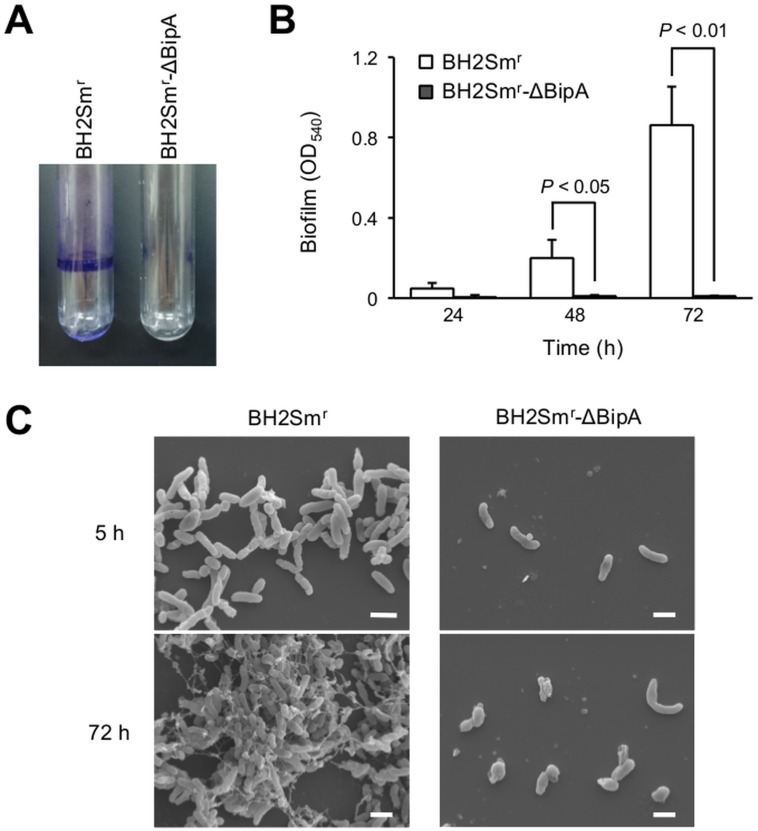
Lack of biofilm formation by BipA mutant.(A) BipA mutant strain BH2Smr-ΔBipA and its parental strain, BH2Smr, were cultured in mSS broth for 72 h under static conditions, and biofilm-forming bacteria were stained with crystal violet. (B) Time course analysis of the levels of biofilm biomass production. The biofilm-associated crystal violet was solubilized and quantified after 24, 48, and 72 h incubation. Data are presented as means ± standard deviations of the results obtained from 3 separate experiments performed in triplicate. Statistical significance was determined using Student’s t-test. (C) SEM analysis of biofilm formation. BH2Smr-ΔBipA and BH2Smr were cultured statically on vertically submerged glass slides in mSS broth. After 5 and 72 h, cell adherence and biofilm growth at the air-liquid interface were visualized by SEM. Scale bars, 1 μm